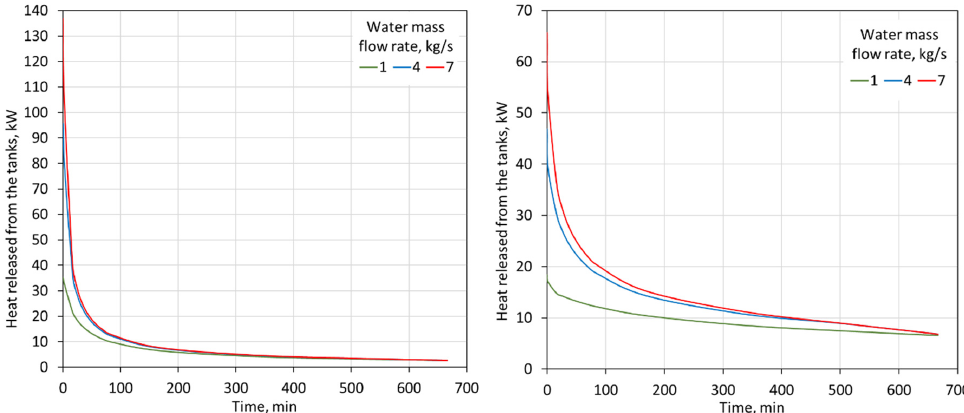
Figure 10. Heat flux released from two 2000-L tanks for 15–85% proportions of heating-PCM and cooling-PCM for heating (left) and cooling (right) modes for different water flow rates through the tanks.